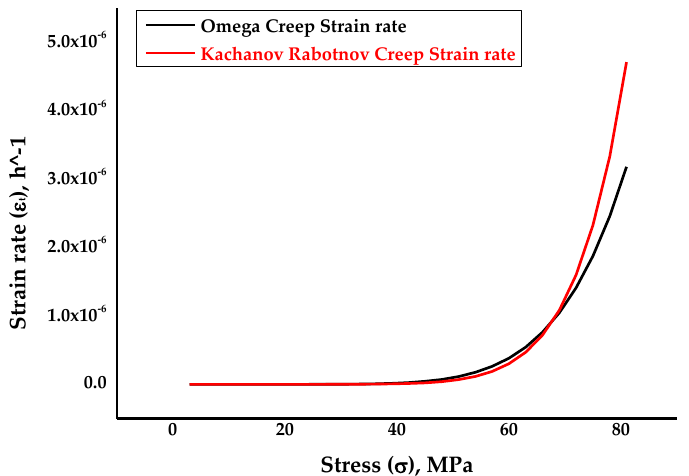
Figure 3. The resultant strain rate vs stress curve obtained following the curve fitting of MPC Omega to Kachanov–Rabotnov–Norton–Bailey model at ω = 0.05 [39].